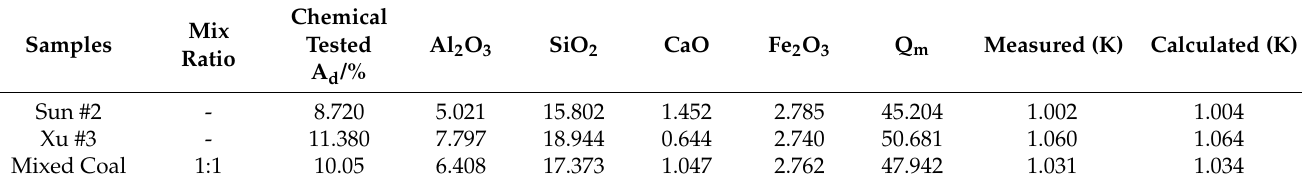
Table 7. Data of mixed coal.